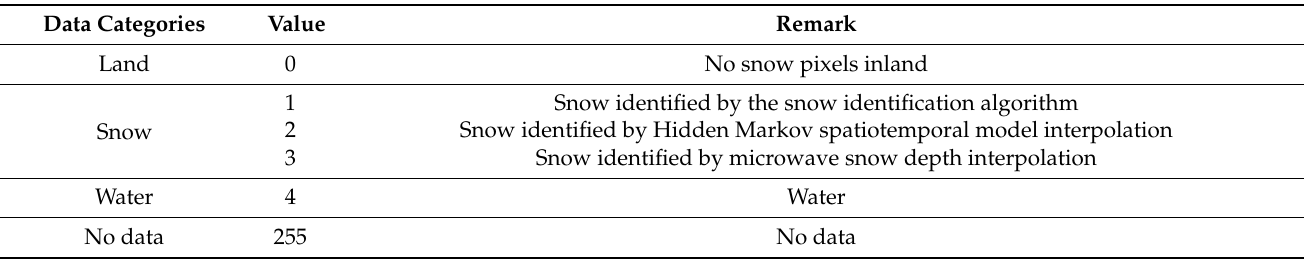
Table 1. NIEER CGF MODIS SCE dataset